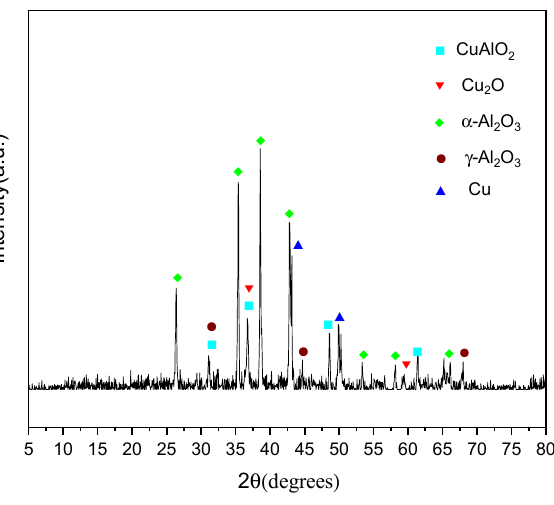
Figure 10. XRD pattern of the reaction products of the nanocomposites (CuO:Al = 1.5:1, GO: 0.5 wt%).